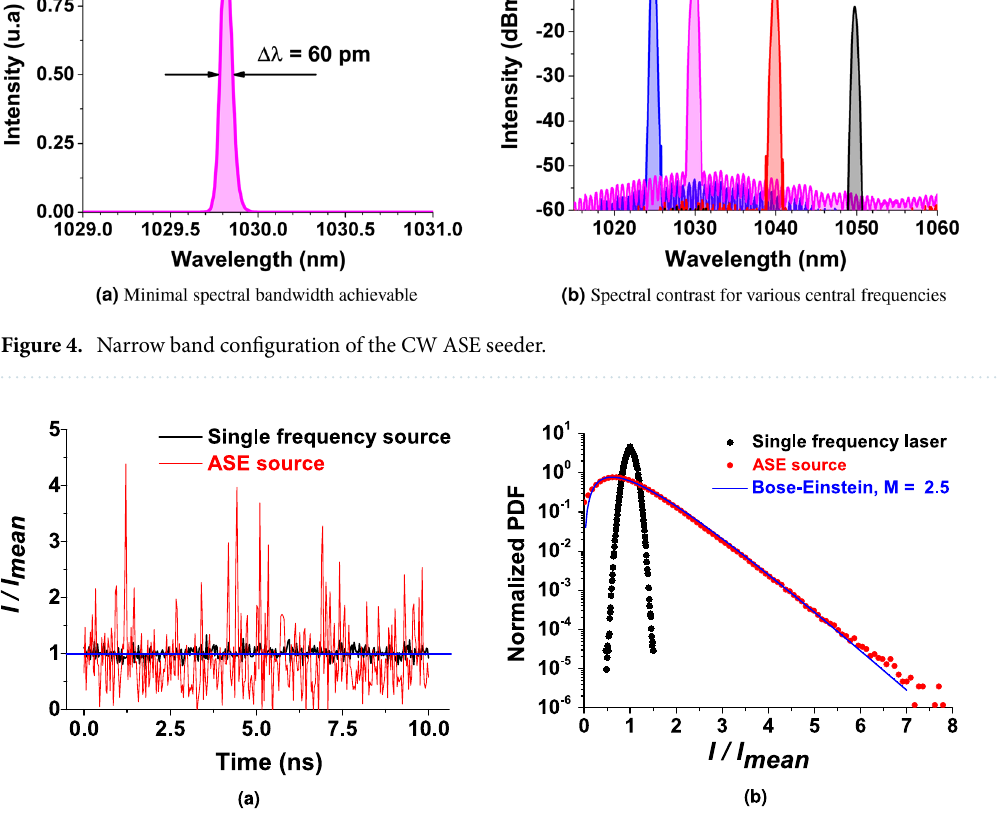
Figure 5. ( a ) Sampled ASE temporal intensity trace from the ASE seed source (red curve) and from the single frequency laser (black curve) normalised to the mean intensity (blue line). ( b ) PDF of the experimental ASE signal (black dots) and the single frequency laser (red dots) together with the Bose–Einstein distribution model with M = 2.5 (blue